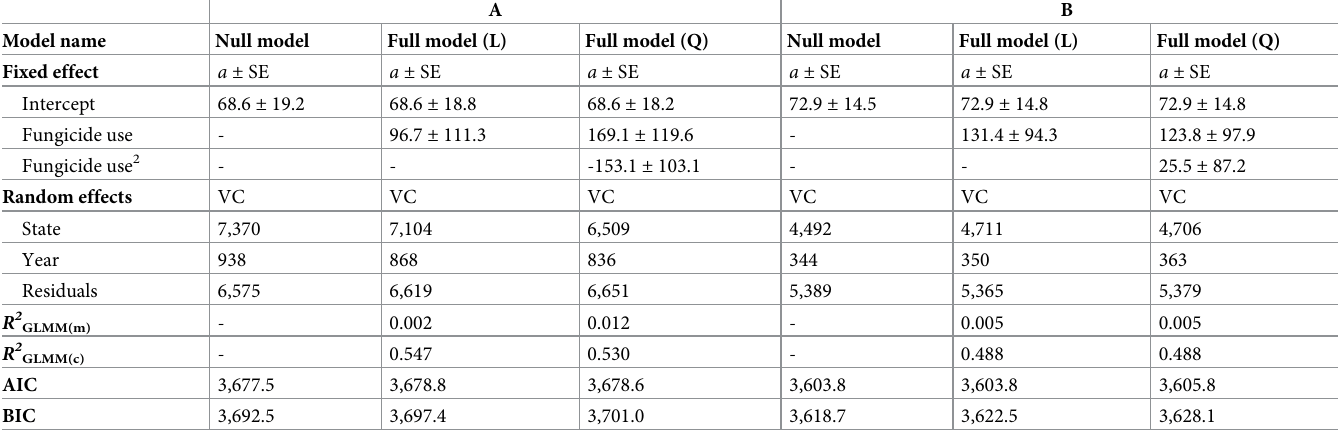
L = linear; Q = quadratic; SE = standard error; VC = variance components. R 2 GLMM( model; AIC = Akaike Information Criterion; BIC = Bayesian information